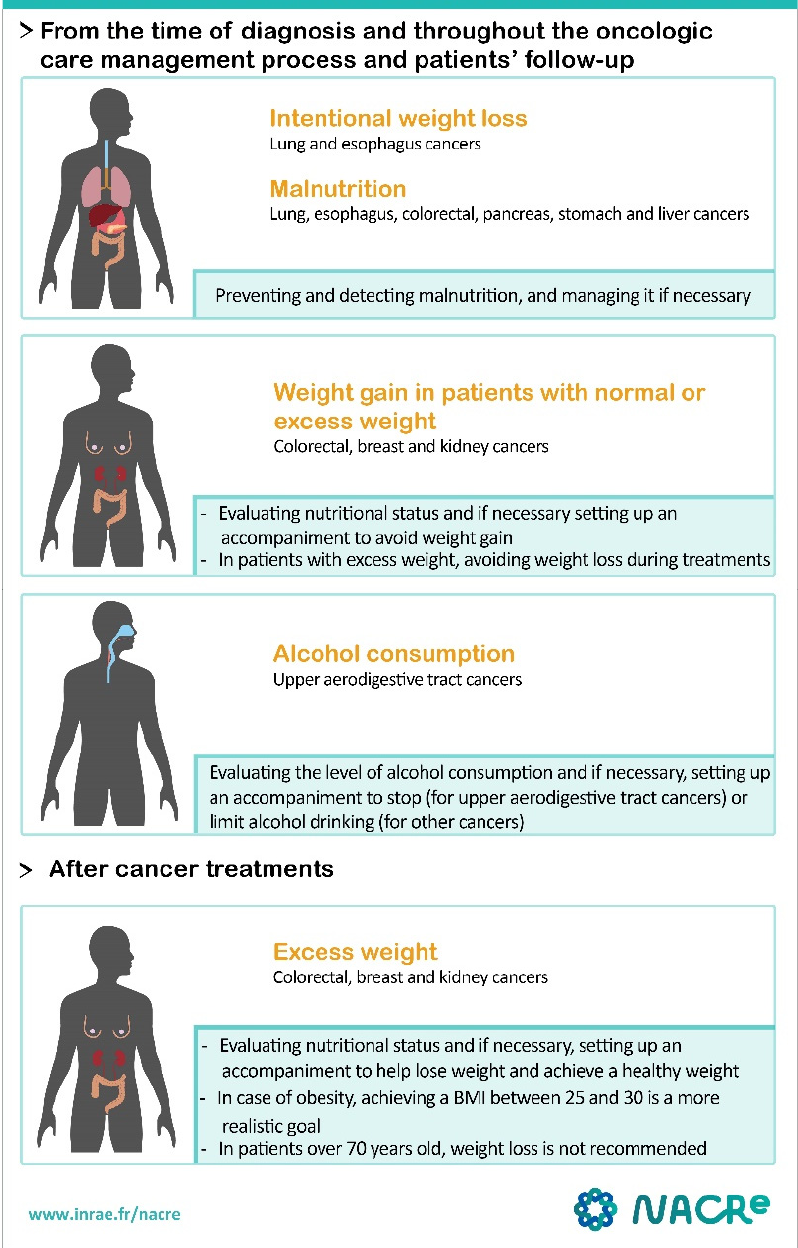
Figure 2. Recommendations: Identification and management of the main nutritional situations at risk in cancer patients by healthcare professionals. Copyright permission has been obtained from the national NACRe Network (Nutrition And Cancer REsearch network). national NACRe Network (Nutrition And Cancer REsearch